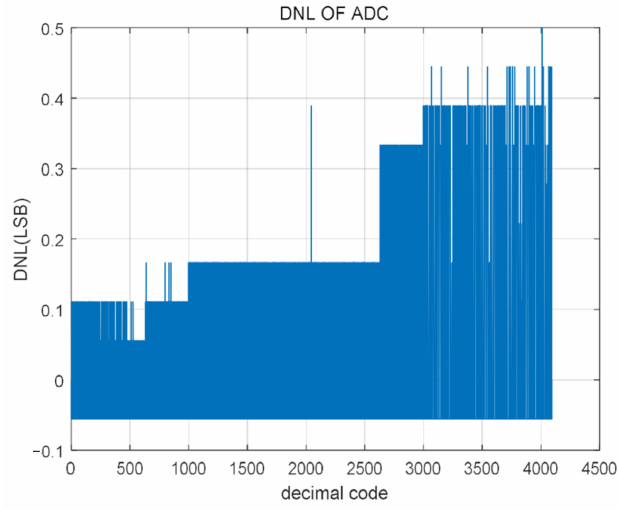
Figure 8. Simulation test results of DNL.